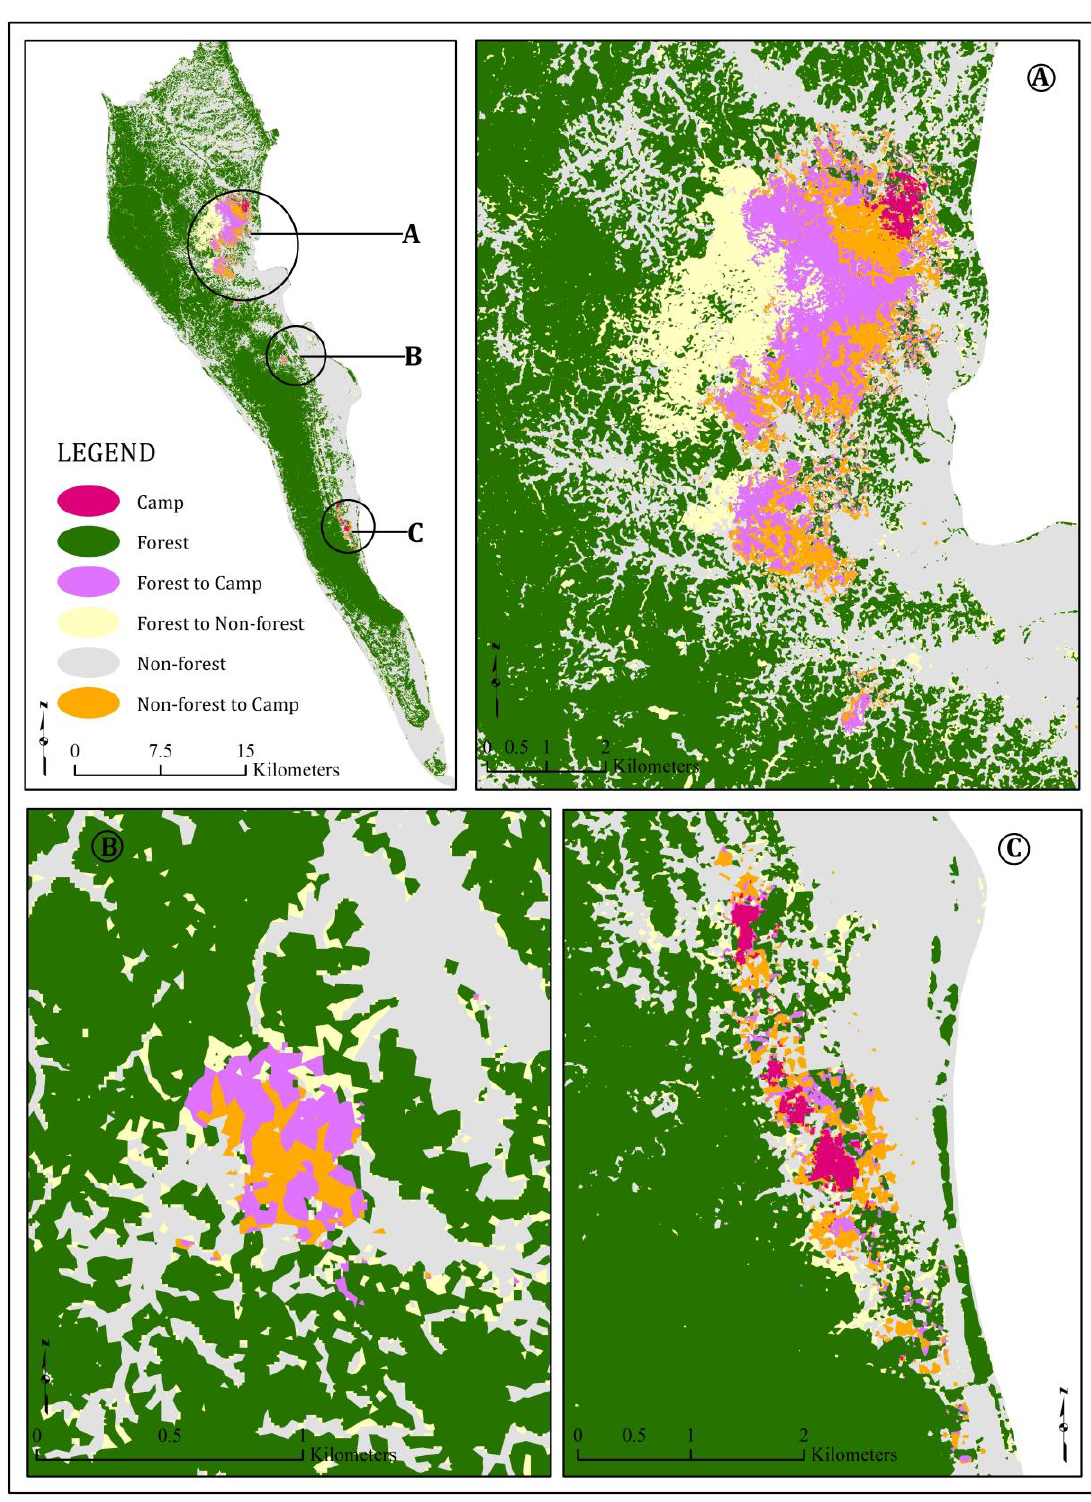
Figure 7. Land cover class conversion map with major land conversion classes (i.e., forest to camp (magenta), forest to nonforest (off-white), and nonforest to camp (orange), depicting land cover conversion and nonconversion between December 2016 and December 2017 at three refugee camp sites: ( A ) Kutupalong–Balukhali, ( B ) Unchiprang, and ( C ) Nayapara–Leda expansion sites.